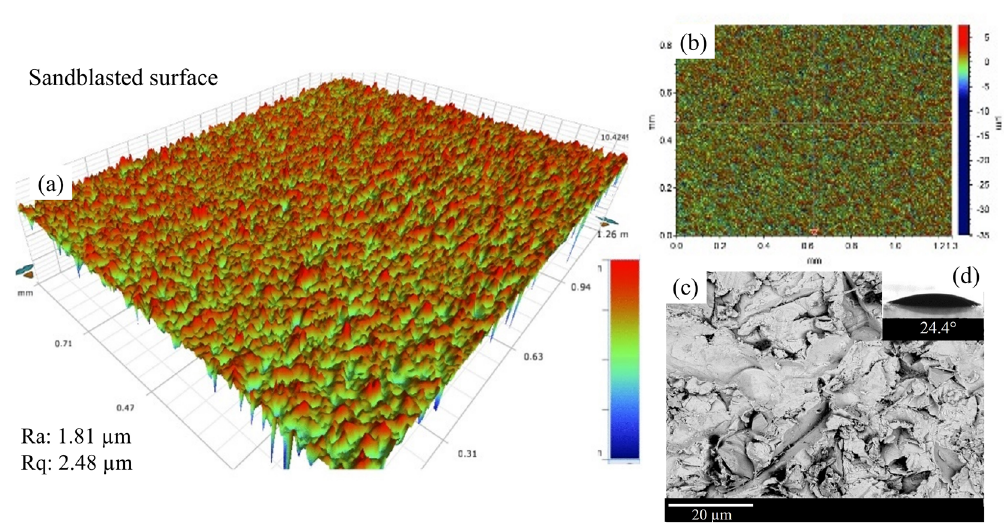
Figure 2. Optical profiling in 3D (a) and 2D (b), top-view SEM images (c), and a contact angle (d) of the sandblasted stainless-steel substrate